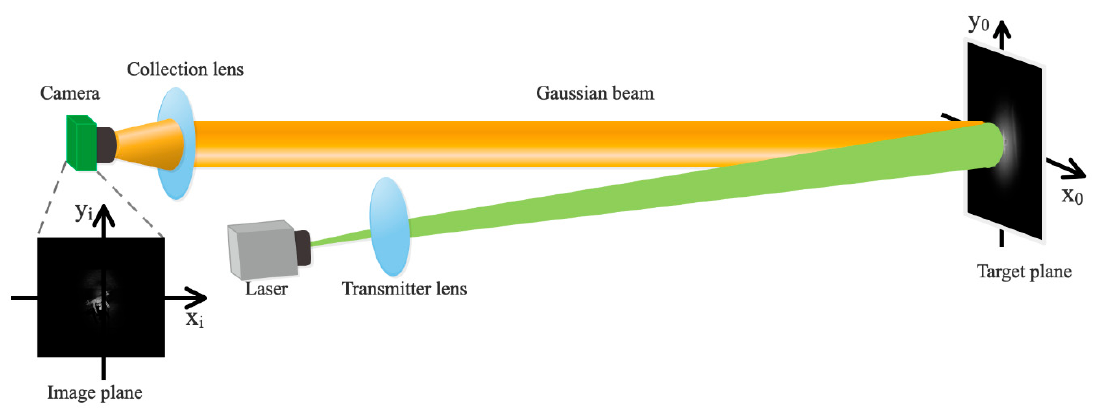
Figure 2. Schematic diagram of our laser active imaging system.